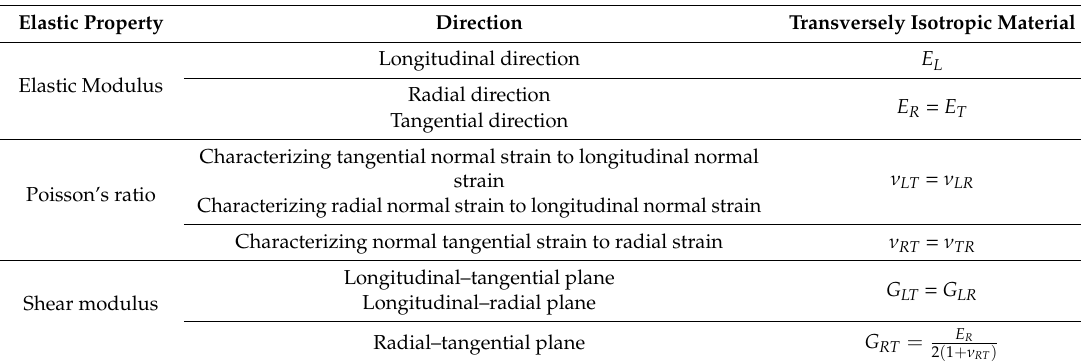
Table 2. Mechanical properties used in FE models and analytical methods to calculate deflections. Characteristic Mechanical Property